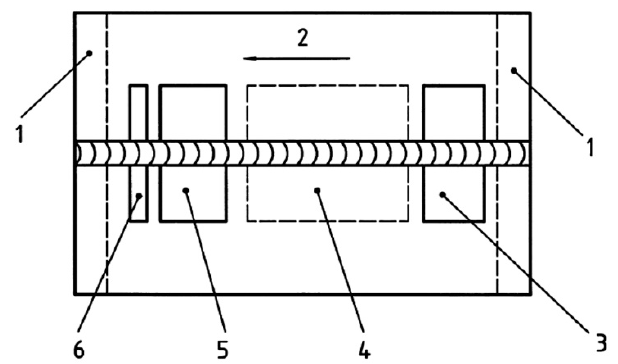
Figure 3. The location of test samples for destructive (DT); 1—discard 25 mm, 2—welding direction, 3—area for one tensile test specimen and bend test specimens (one for bending with tensile from the face of the weld, one for bending with tensile from the roof of the weld), 4—area for impact test specimens, 5—area for one tensile test specimen and bend test specimens (one for bending with tensile from the face of the weld, one for bending with tensile from the roof of the weld), 6—area for metallographic (macroscopic and microscopic) test specimens and one hardness test specimen.